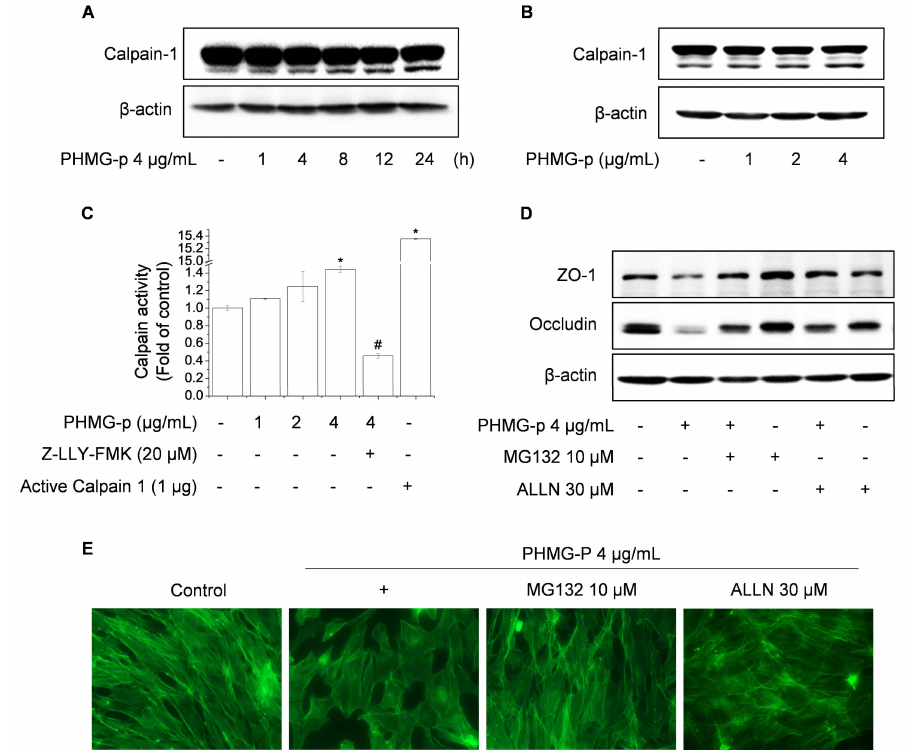
Figure 2. Activated calpain-1 is required for PHMG-p-mediated degradation of tight junctions. Cells were treated with 4 µ g / mL PHMG-p for 1–24 h ( A ) or 1–4 µ g / mL PHMG-p for 4 h ( B ), then assessed by western blotting. (C) Cells were treated with 1–4 µ g / mL with or without active calpain-1